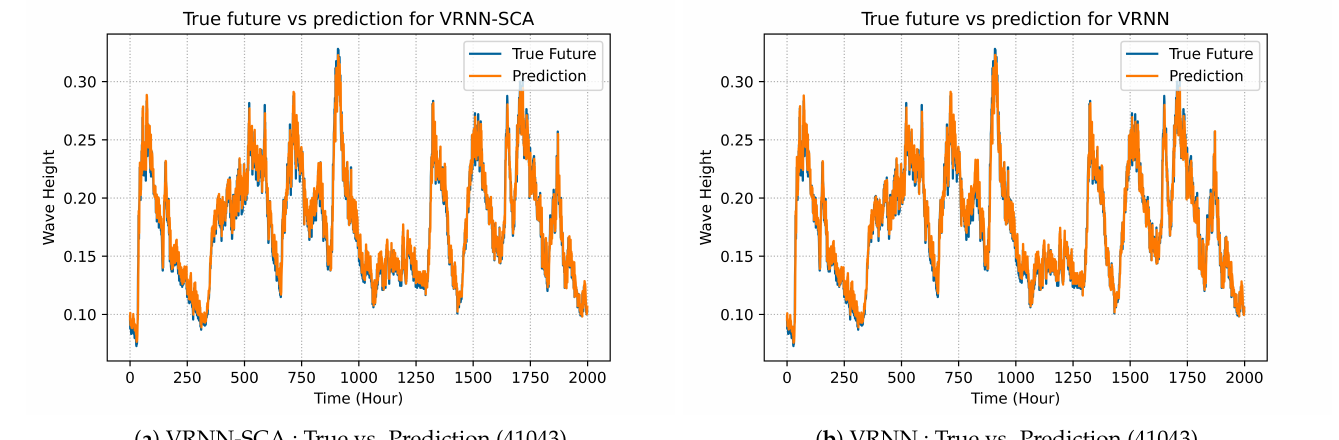
Figure 8. Comparison of GRU models on dataset 41040.